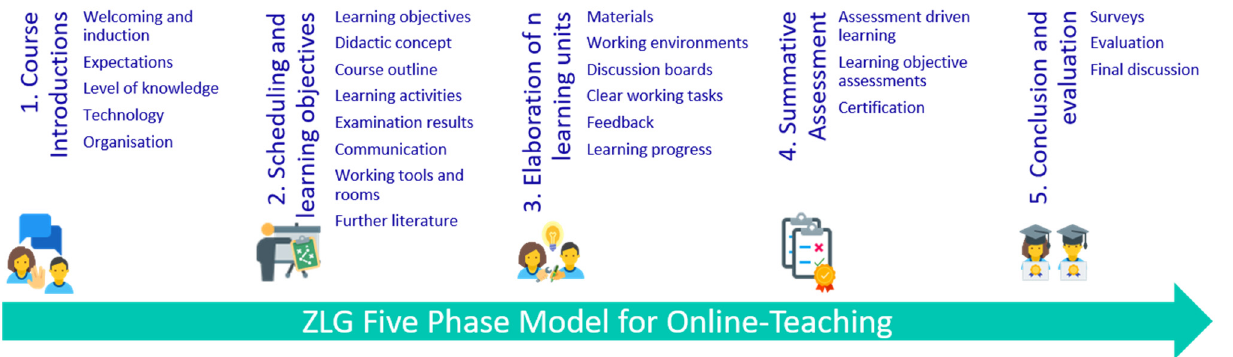
Figure 2. ZLG Five Phase Model for Online-Teaching based on